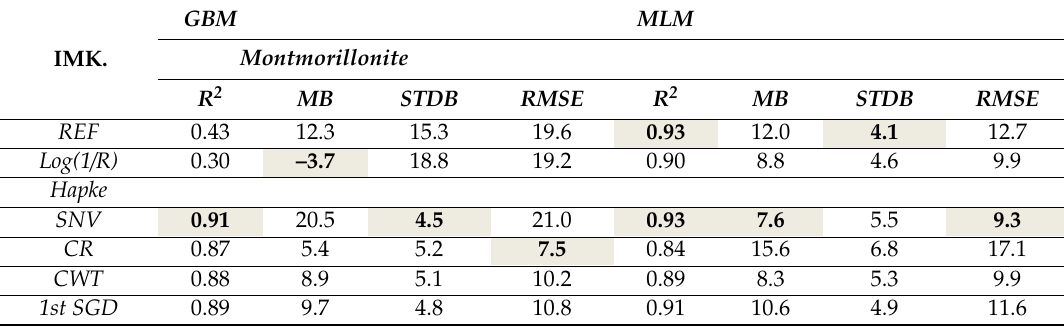
Table 9. Performances of non-linear unmixing methods to estimate montmorillonite abundances for IMK intimate mixtures with di ff erent combinations of spectral preprocessings (best results in grey cells with bold